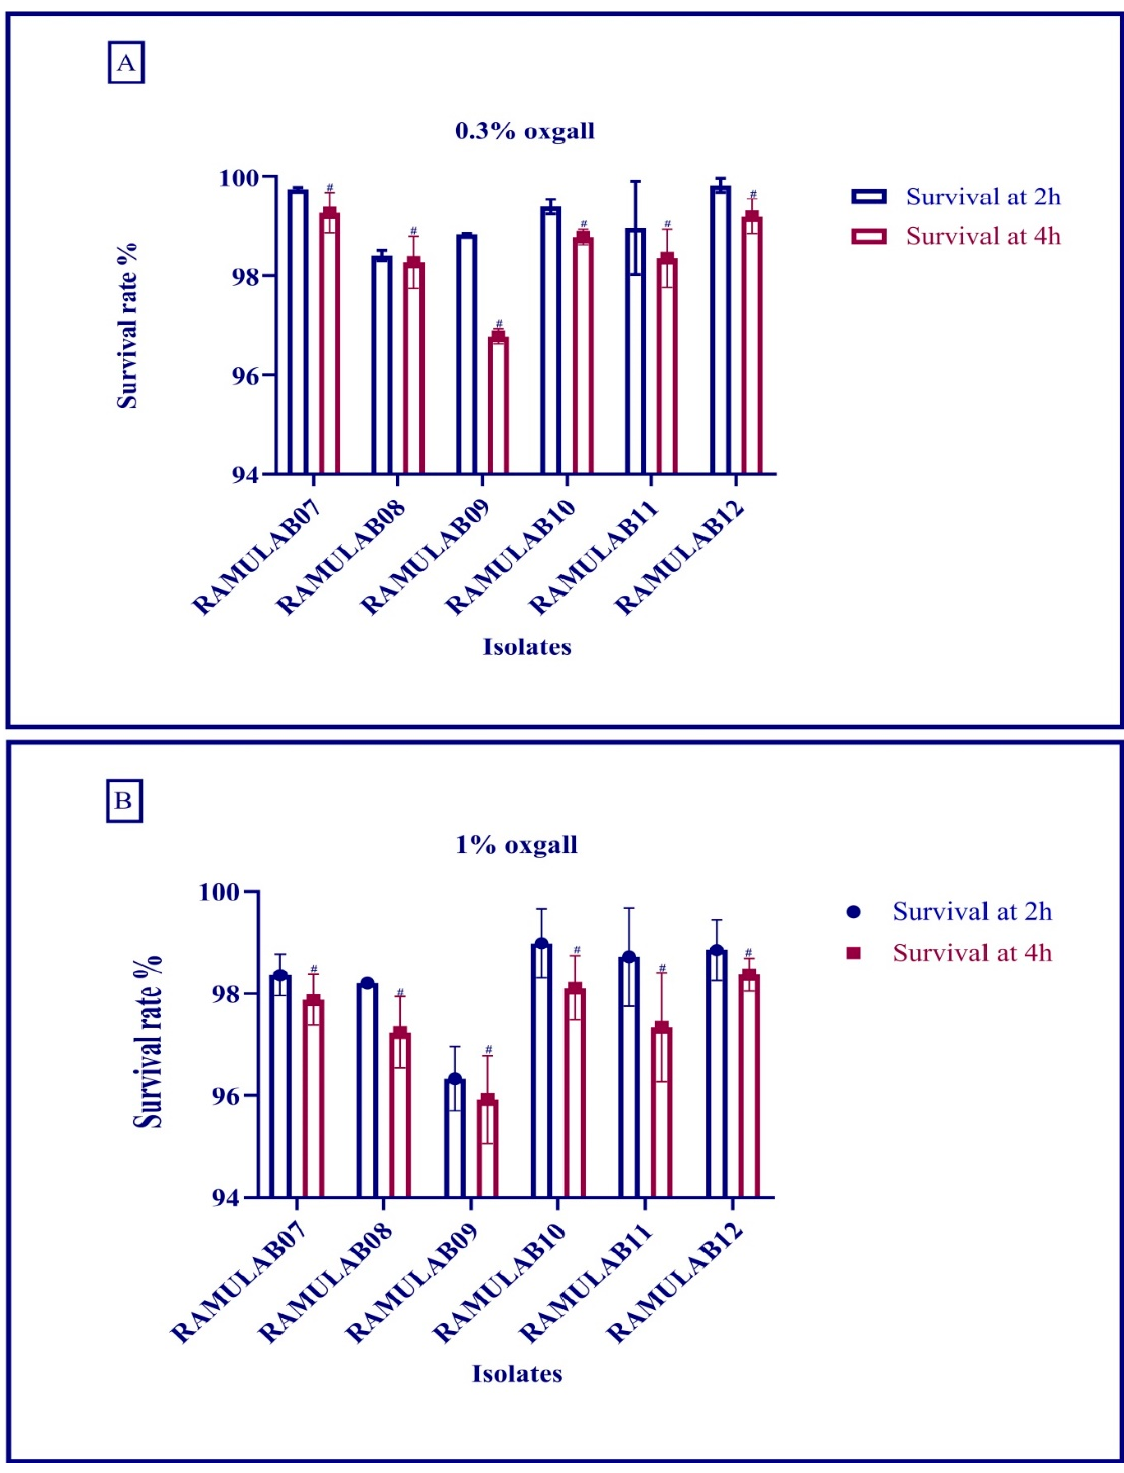
Figure 3. Acid and bile survival rate of LAB strains isolated from dosa batter sample with an acidic pH 2 value and under different bile salt conditions: ( A ) 0.3%, ( B ) 1% bile salt concentration conditions for 2 and 4 h at 37 °C in MRS agar plates. Data are expressed as the mean ± SD. Means in survival rate with time interval of 2 h with superscripts (#) are significantly different ( p ≤ 0.05), as separated by Duncan multiple range test.